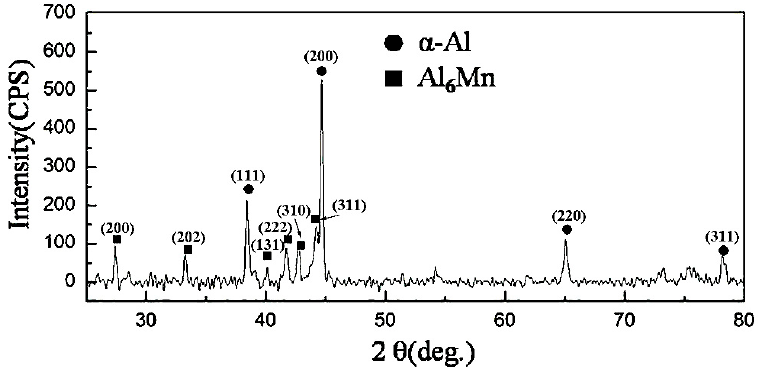
Figure 8. Dendrite microstructure at the center of the cross-section of the cylindrical sample in suction casting Al–8 wt.% Mn alloys: ( a ) SEM BSE; ( b ) SEM BSE; ( c ) TEM BF; ( d ) TEM EDS.